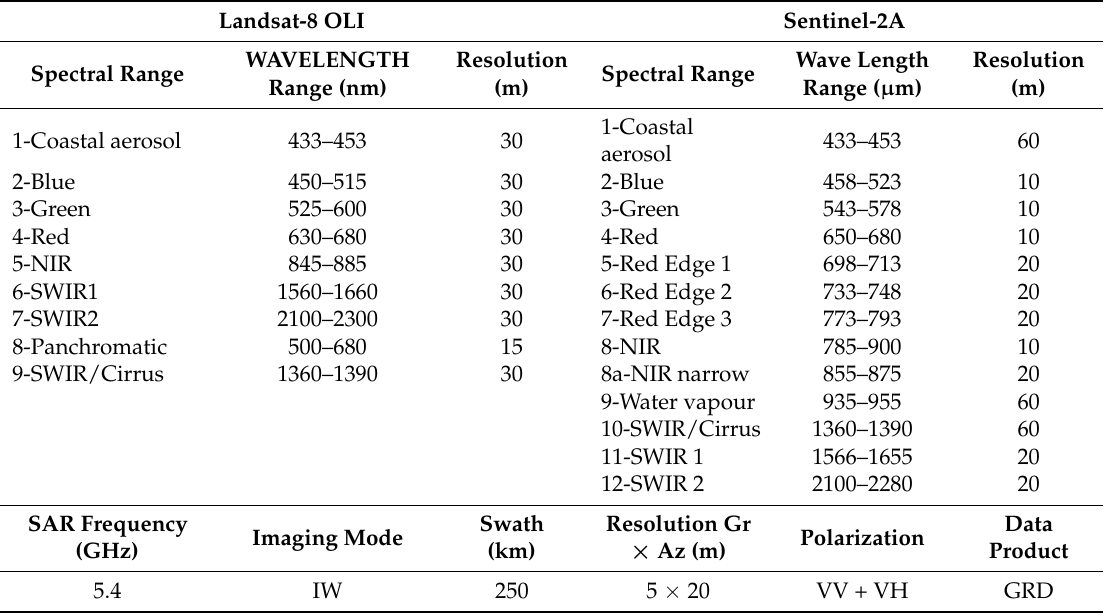
Table 1. The spectral bands and resolutions of optical Landsat-8, Sentinel-2A, and radar Sentinel-1A datasets used in this